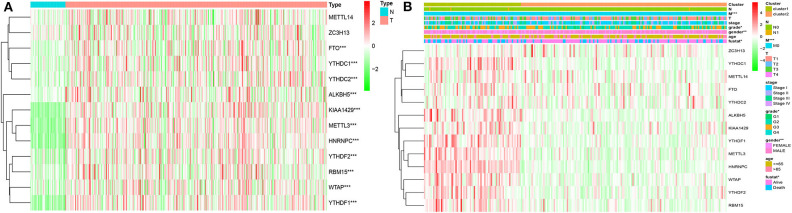
Kaplan-Meier curves for overall and disease-free survival of TCGA HCC patients by the presence and absence of (A,B) mutation and/or CNVs of m6A regulatory genes, (C,D) amplification/copy number gain of VIRMA.